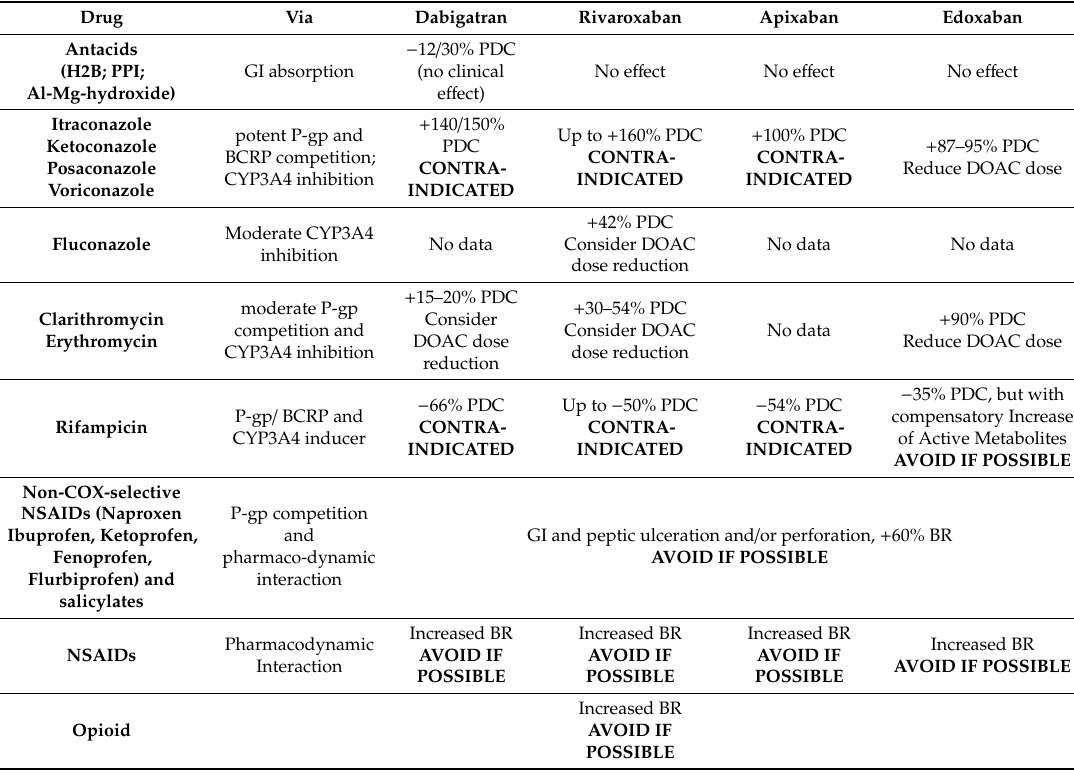
Table 3. Potential interactions of oral anticoagulants with drugs used or prescribed in